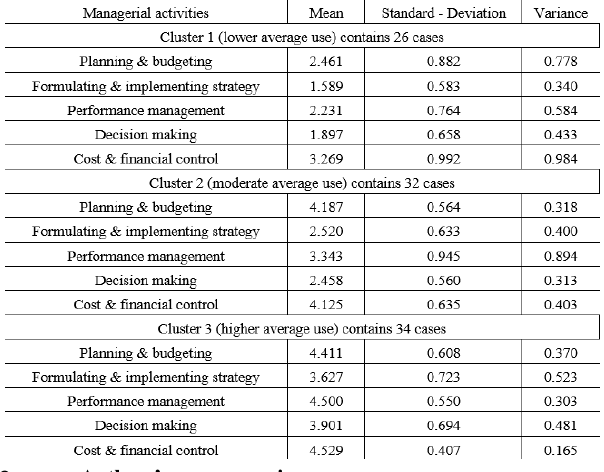
Source : Authors’ own processing